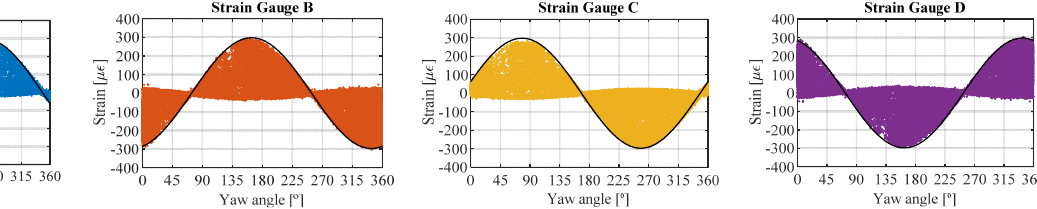
Figure 8. Ten-minute average strain signal of strain gauges A to D (see sensor positions in Figure 4c).